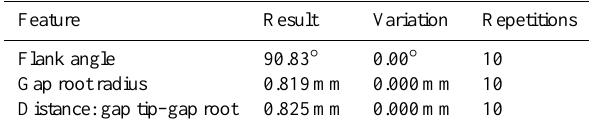
Table 2. Results of feature